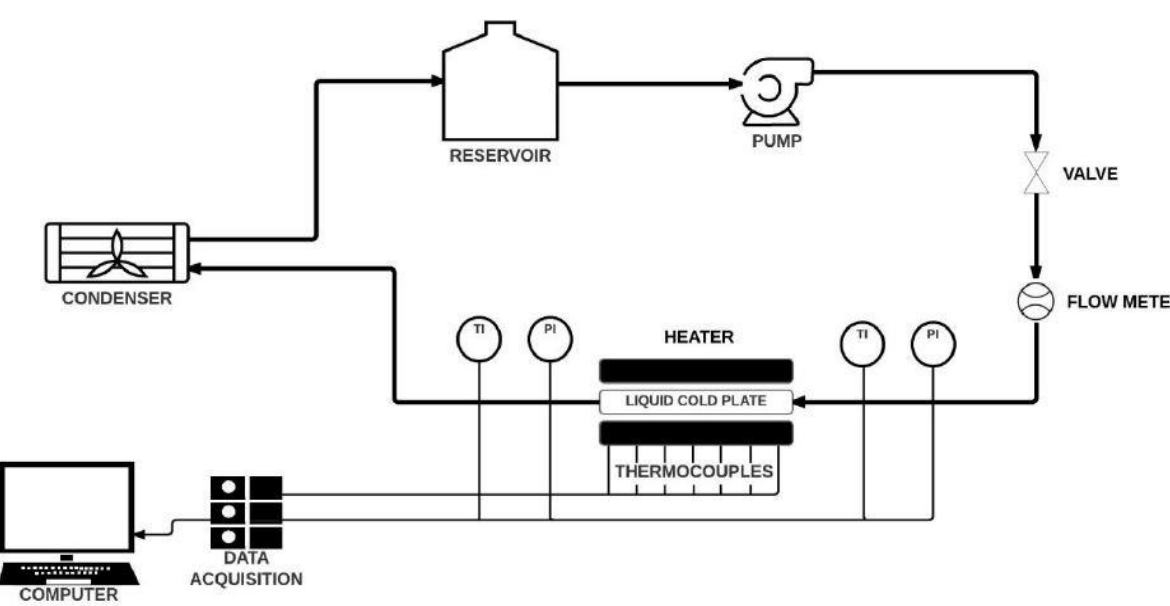
Figure 2. Image of the experimental configuration.